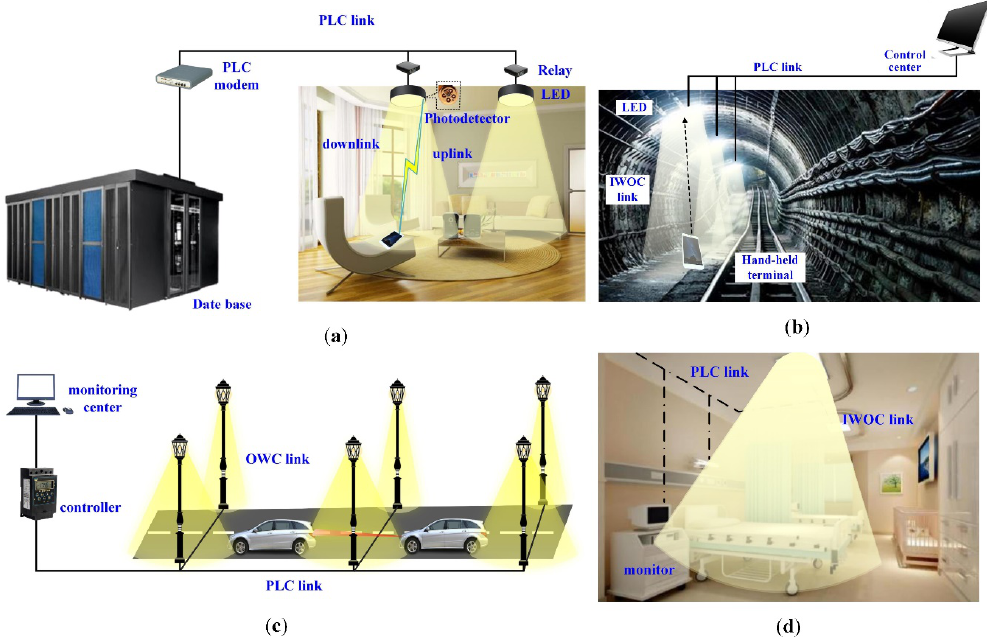
Figure 1. The application scenarios of power industry optical wireless systems: ( a ) indoor scenario; ( b ) tunnel scenario; ( c ) outdoor scenario; ( d ) hospital scenario.